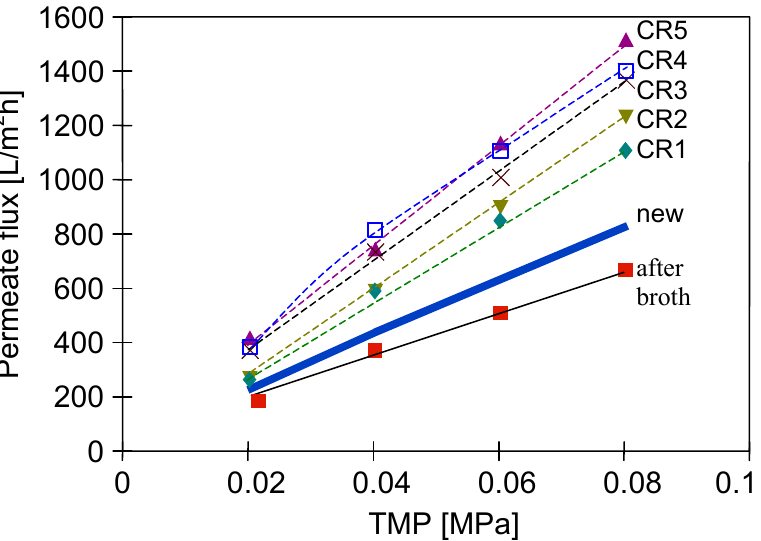
Figure 19. SEM image of PP S6/2 membrane (module M3) surface covered by biological deposit with yeast cells after MF process of yeast suspensions.